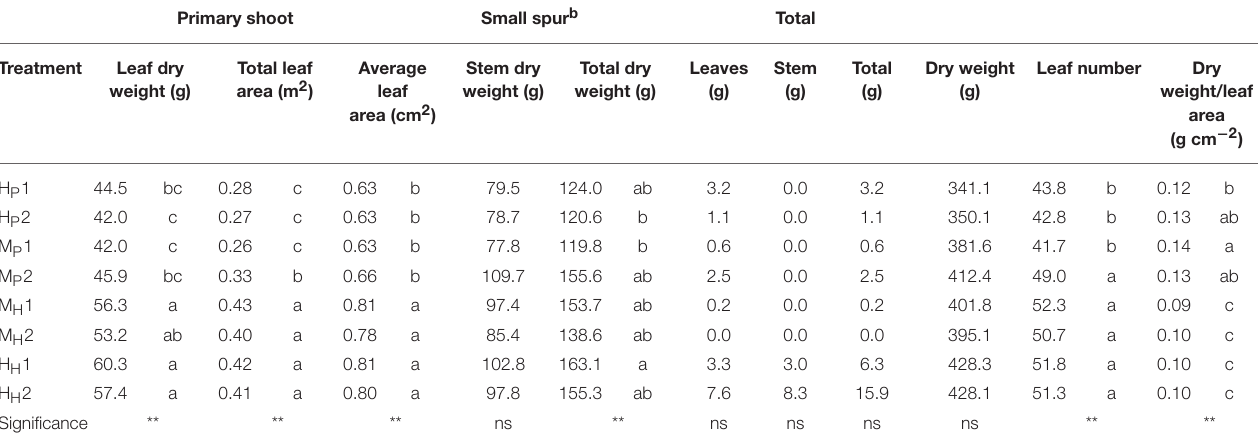
TABLE 4 | Summary of the final dry weight of component parts of primary axes of bi-axis pear trees, considering the interaction between plant type (Homogeneous, H, Mixed, M), genotype (‘Hosui,’ H , ‘PremP009,’ P ) and shoot position (1, lower primary axis; 2, upper primary